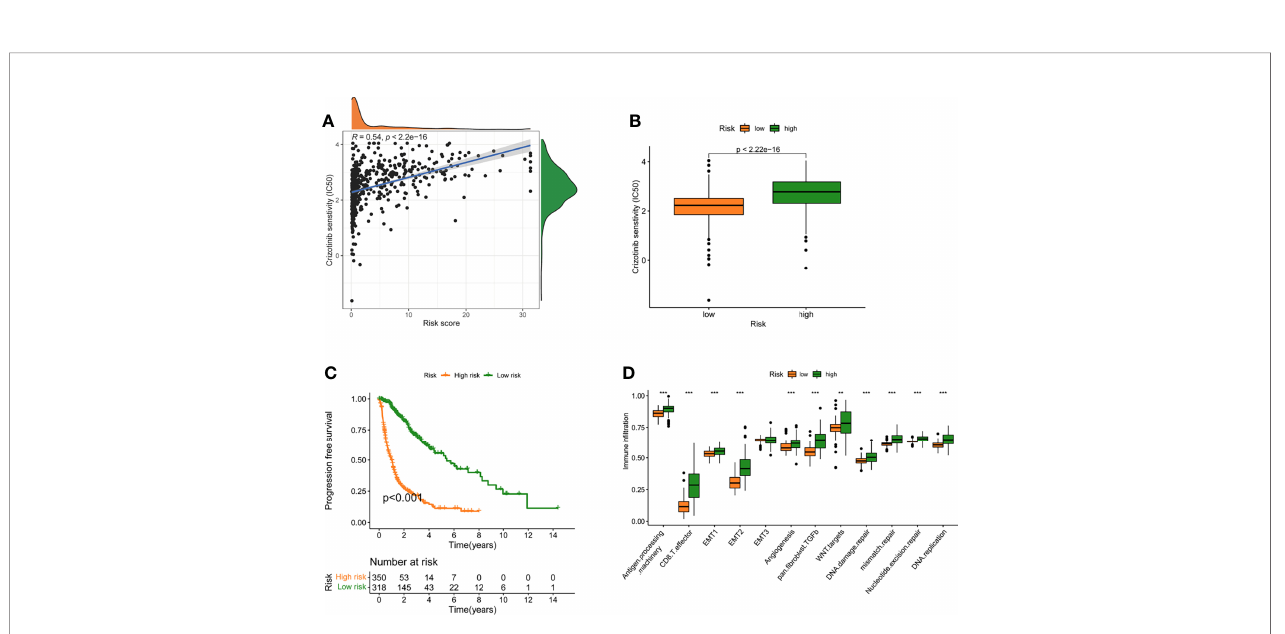
FIGURE 6 | A model offatty acid metabolism in the context of chemotherapy. (A) The relationship between patient risk ratings and crizotinib ’ s projected IC50 value. (B) The disparities in crizotinib response between groups with poor and good risk scores. (C) The TCGA cohort ’ s progression-free survival (PFS) was compared between low- and high-risk score groups. (D) Variation in stroma-activated networks between groups with low and high-risk scores (**p < 0.01; ***p <